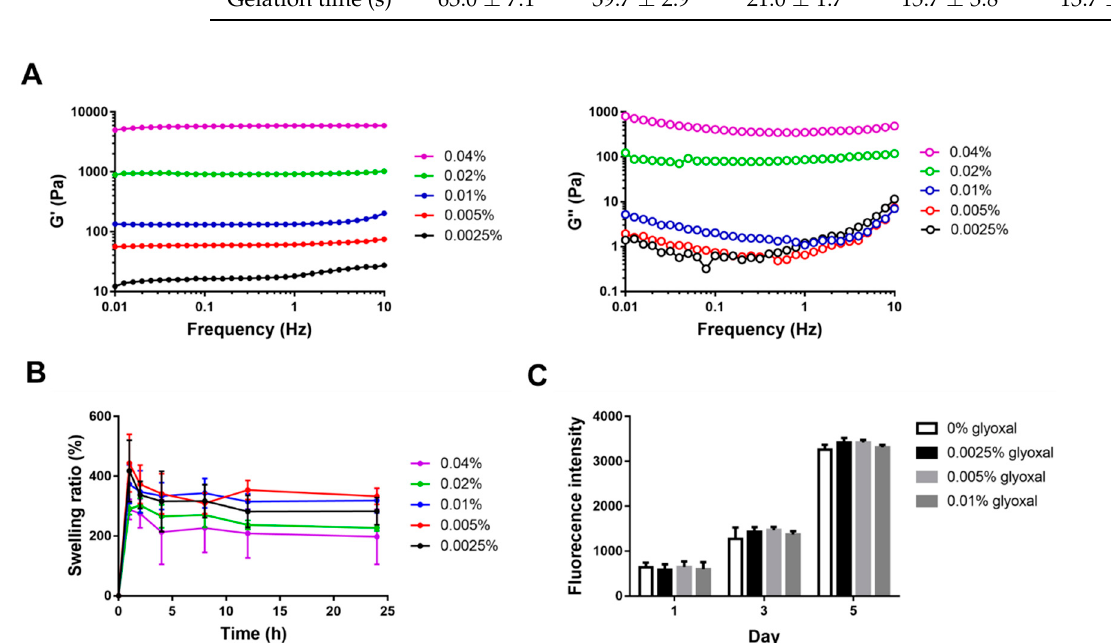
Figure 3. The mechanical properties and cytotoxic effects of CS-GE hydrogel crosslinked with different glyoxal concentra- tions. ( A ) In a frequency sweep mode, the viscoelastic properties of the hydrogels, including the storage modulus (G ′ ) and the loss modulus (G ′′ ), were analyzed. ( B ) Swelling ratio of the hydrogels. ( C ) Cytotoxicity of different concentrations of glyoxal in the medium was tested by the Alamar Blue assay to reveal the viability of Hs68 fibroblasts.